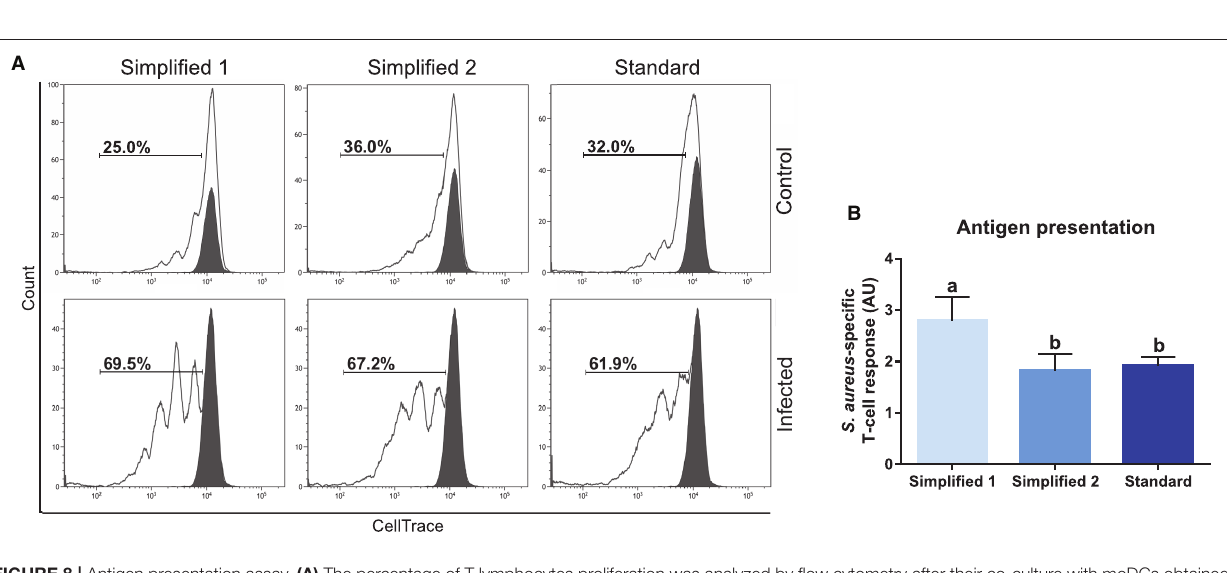
FIGURE 8 | Antigen presentation assay. (A) The percentage of T lymphocytes proliferation was analyzed by flow cytometry after their co-culture with moDCs obtained by three different approaches. Black and white peaks correspond to lymphocytes alone (non-proliferating control) and exposed to moDCs, respectively. The gates indicate the percentage of proliferating lymphocytes. Control (upper) and infected (lower) lines correspond to lymphocytes co-cultured with infected or non-infected moDCs. Proliferation controls are shown in Supplementary Figure 2 . Histograms show the results of one representative experiment. (B) The bar plot depicts the levels of S. aureus- specific T-cell response. Data were calculated as a ratio between the percentage of T-cell proliferation upon co-culture with infected and control moDCs. Samples from three different animals were used. Different letters represent mean statistically significant difference ( p < 0.05). Error bars represent